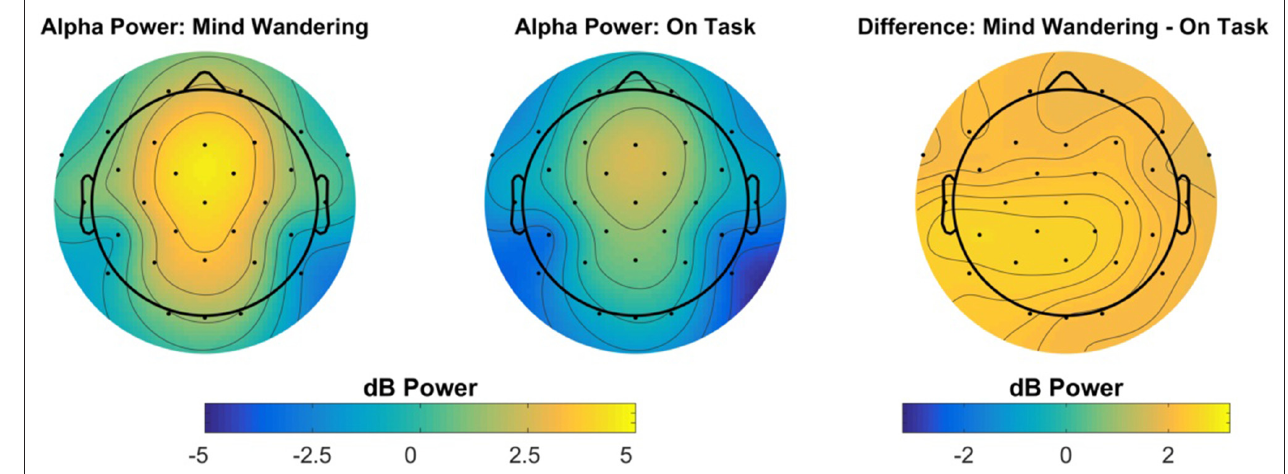
FIGURE 9 | Topography of alpha power preceding “mind wandering” vs. “on task” responses. The right-most panel represents the topography of the difference between “mind wandering” and “on task”